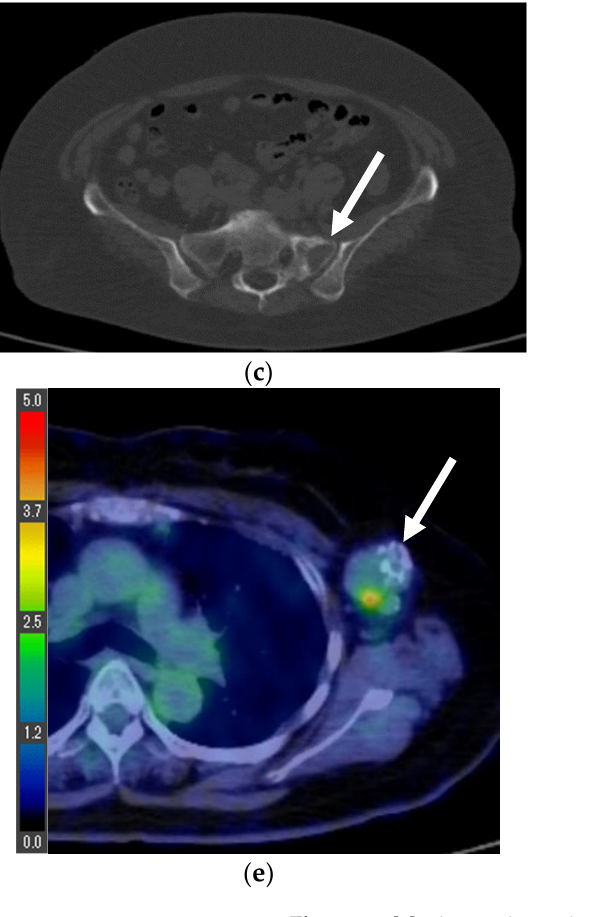
Figure 6. Maximum intensity projection (MIP) of 18 F-FLT PET ( a ) and 18 F-FDG PET 10 months prior ( b ). 18 F-FLT accumulation within an osteolytic lesion (( c ), arrow) on the left side of the sacrum was lower than that in the physiological bone marrow (( d ), arrow). In addition, left axillary lymph node accumulation with coarse calcification was found on 18 F-FDG PET/CT (( e ), arrowhead); however, accumulation on 18 F-FLT PET/CT did not increase (( f ), arrowhead), suggesting inflammation. Patient 8 (Figure 6).